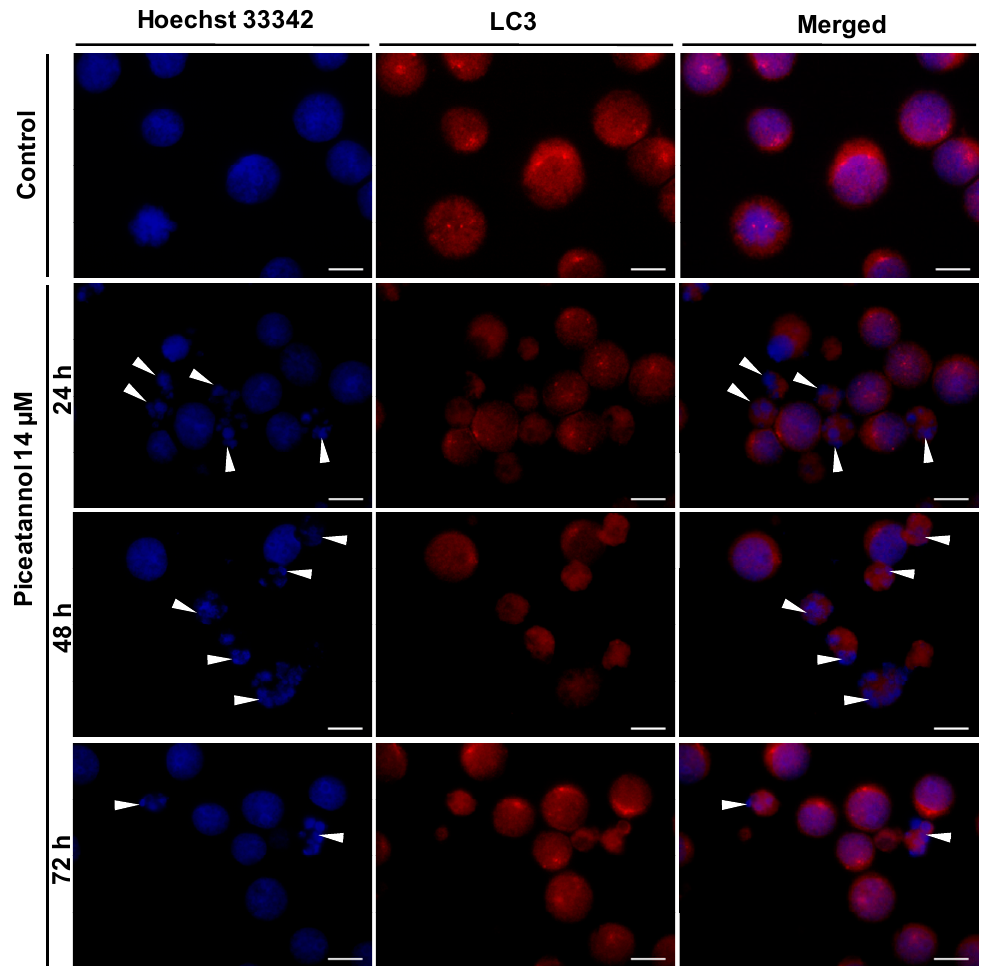
Figure 5. Detection of LC3 protein in HL-60 cells. Cells were treated with piceatannol (IC 90 = 14 µM) for 24, 48, and 72 h. Cells were incubated with primary anti-LC3 antibody and subsequently with Cy3-conjugated secondary antibody. Following staining with Hoechst 33342, cells were examined by fluorescence microscopy. Data are representative of three independent experiments. Bars, 10 µm; control—untreated cells; arrowheads–cells with fragmented nuclei.